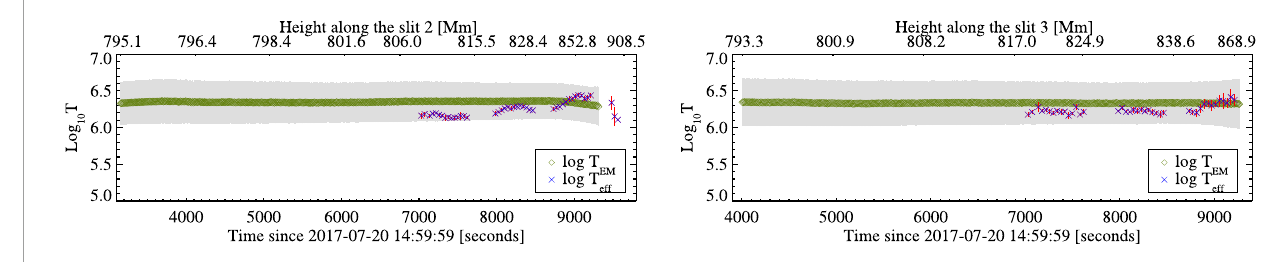
FIGURE 8 The evolution of log temperature of the CME core with height and time. The green diamond symbols show the variation of the EM-weighted log temperature (log T EM ) averaged over the spatial direction along the blue curve shown in Figure 3 . The grey shaded region is the effective width of the distribution in log T space. The blue cross symbols show the variation of log effective temperature averaged over the spatial direction along the blue and the cyan curves shown in Figure 6 , and the red bars are one sigma deviation in log T eff values.